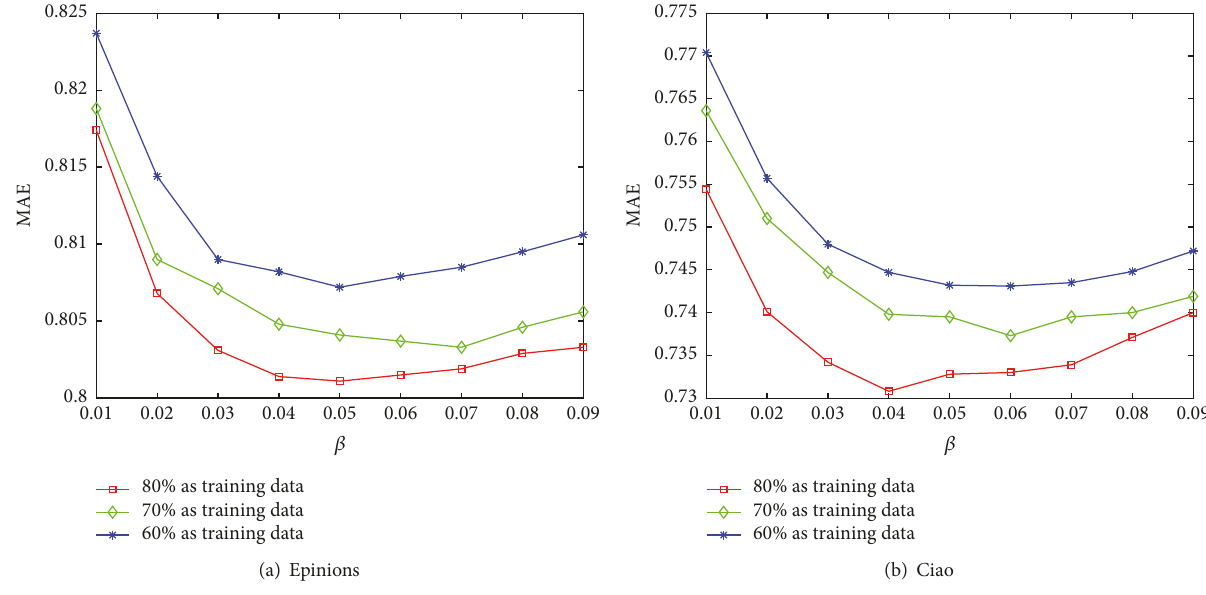
Figure 3: The impact of parameter 𝛽